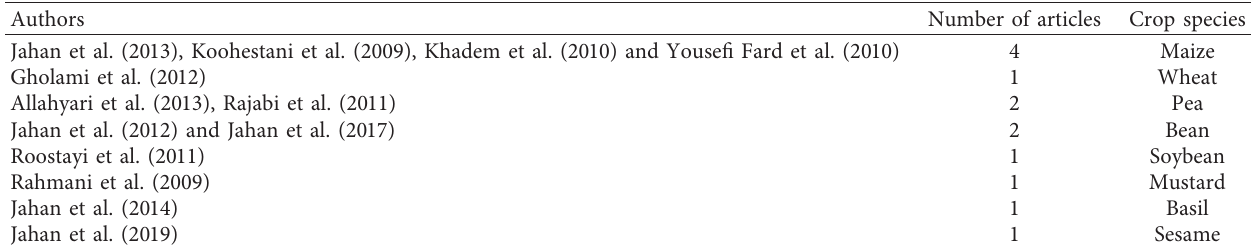
Table 1: Some information on the articles used in the meta-analysis of the effect of water superabsorbents. Authors